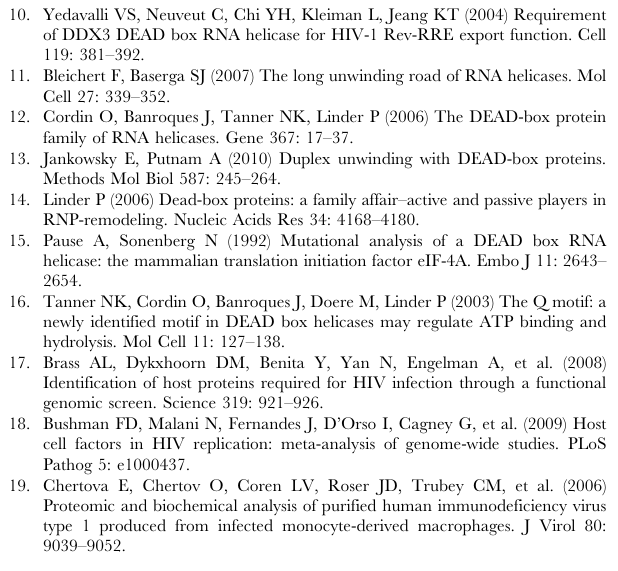
Figure S1 DDX5 is important for HIV-1 replication. A . The effect of DDX5 knockdown on HIV-1 p24 production. Top, the supernatants from 293T cells transfected with pNL4-3 D Env- GFP in the presence of DDX5-siRNA (GFP-siRNA as a control) were collected at 48 h p.t. and analyzed with p24 ELISA kit.